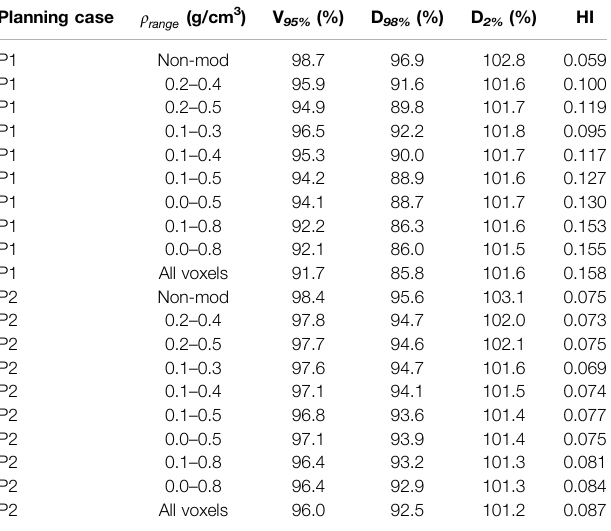
TABLE 6 | Dosimetric indices for proton plans for patients P1 and P2 and P mod (cid:1) 0.400 mm for variable values of ρ range .